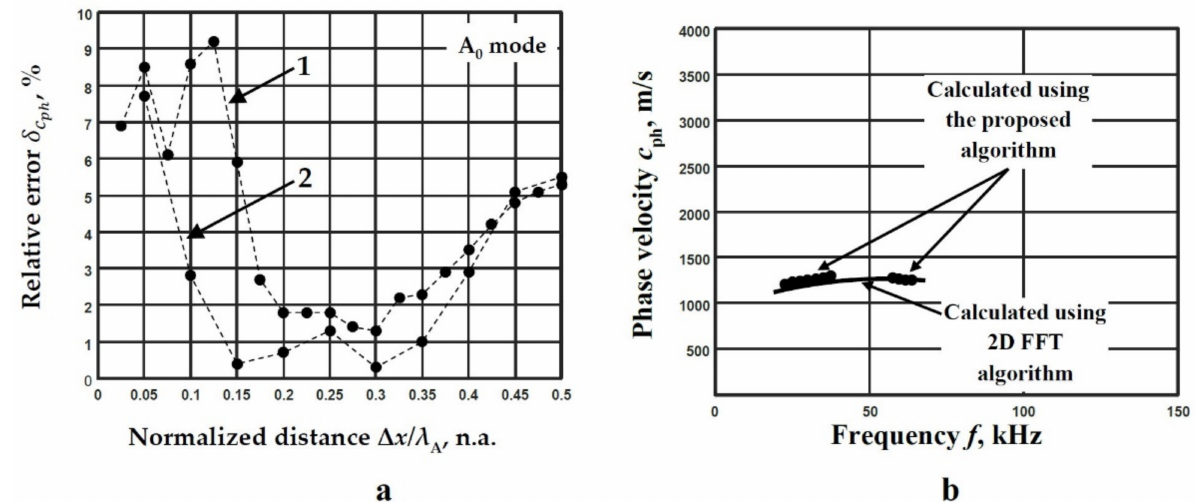
Figure 14. The deviation of the obtained phase velocities from the values obtained by the 2D-FFT method in different frequency ranges: 1—22–38 kHz, 2—57–64 kHz ( a ), the reconstructed dispersion curves of the phase velocities using the proposed algorithm (dots) and by calculating peak values of spectrum magnitude from 2D-FFT (line) ( b